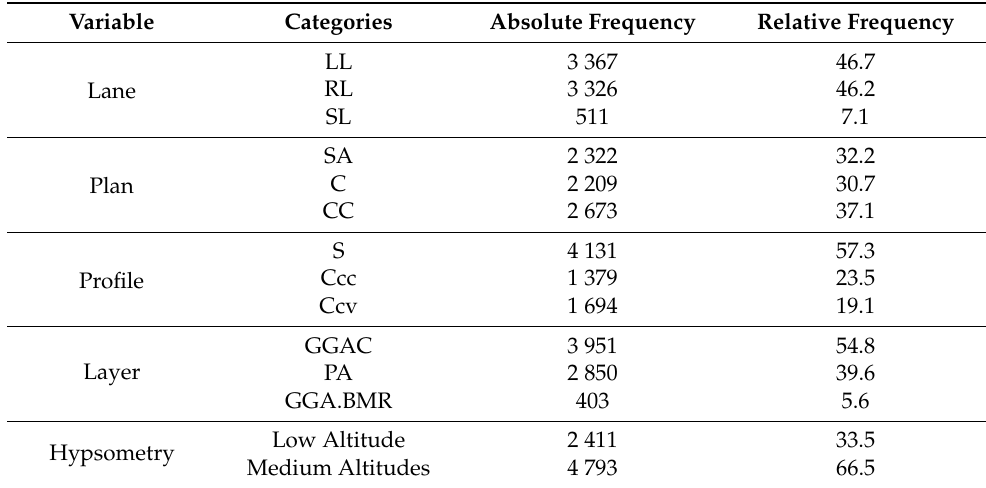
Table 6. Frequencies of the qualitative